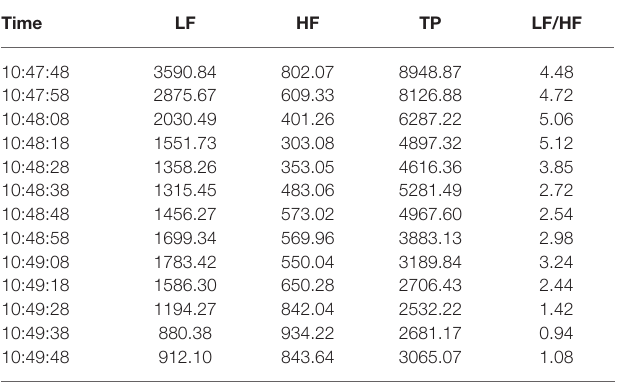
TABLE 1 | Standardized HRV spectral variables for a stress period in a student writing the test. Time